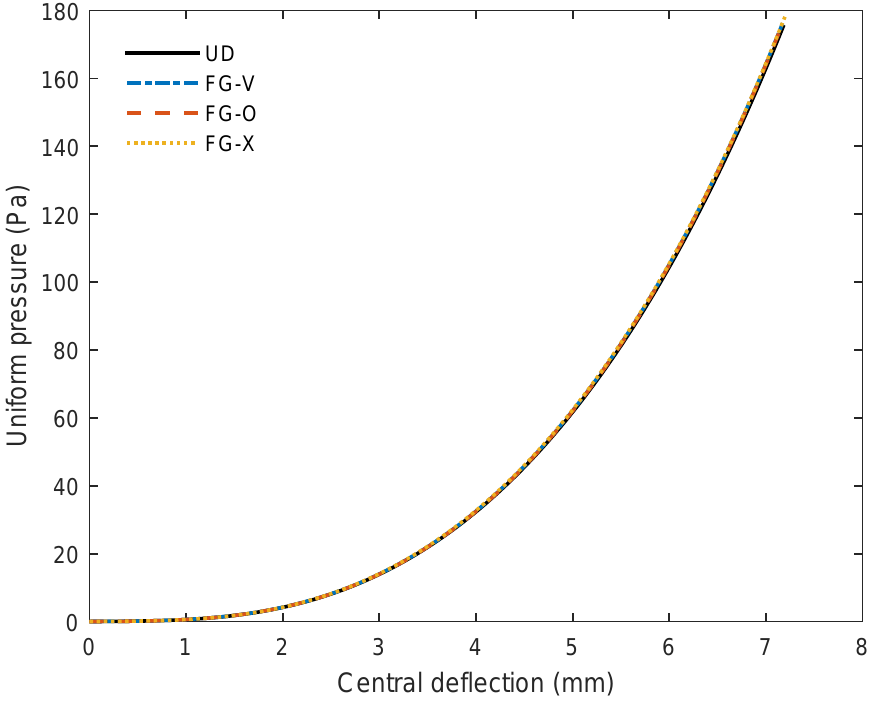
Figure 9. Effect of CNTs distribution on nonlinear response of the fully clamped FG-CNTRC cylindri- = 0.11, h = 0.5 mm, κ = 0.04. cal membrane with V ∗ CNT